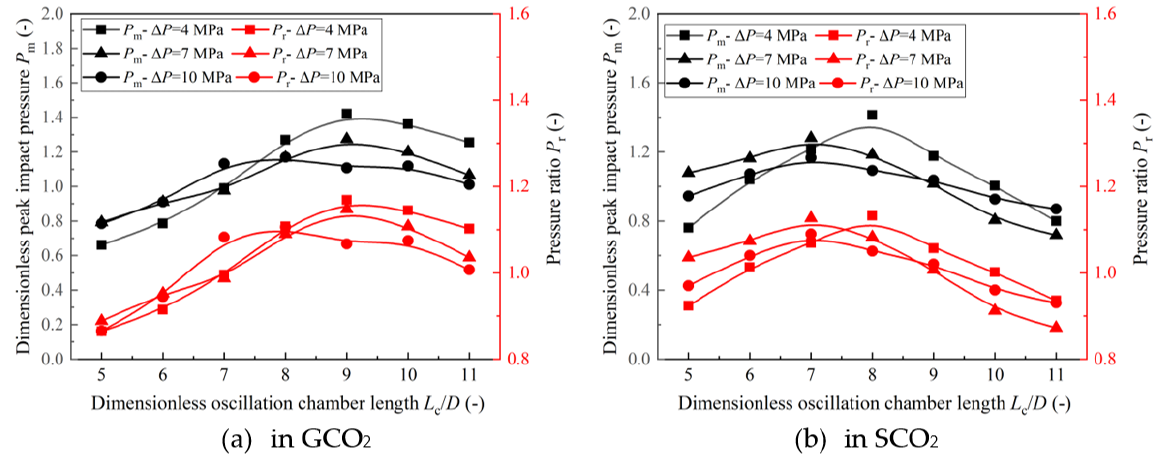
Energies 2021 , 14 , x FOR PEER REVIEW 9 of 16 Figure 5. Dimensionless peak impact pressure and pressure ratio as a function of the chamber length: ( a ) in GCO 2 and ( b ) in SCO 2 . Experimental conditions: ∆ P = 4–10 MPa, 5 ≤ L c / D ≤ 11, and P a = 6 or 8.5 MPa.